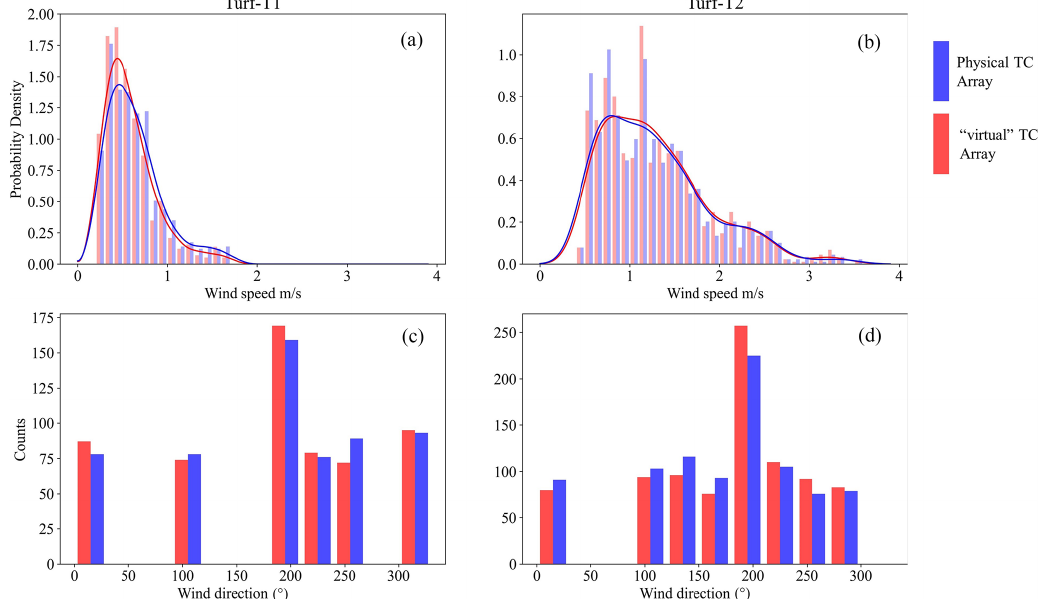
Figure 5. TURF-T1 and TURF-T2 brightness temperature accuracy assessment – comparison of wind speed ( a, b : metres per second) and wind direction ( c, d : degrees) of the physical TC array (red) to the virtual TC array (blue) for TURF-T1 and TURF-T2. It is evident that the lag correlation using the virtual arrays depicts similar wind speed and direction as the physical TC array, which measures air temperature approximately 1.5cm above the ground in both experiments.